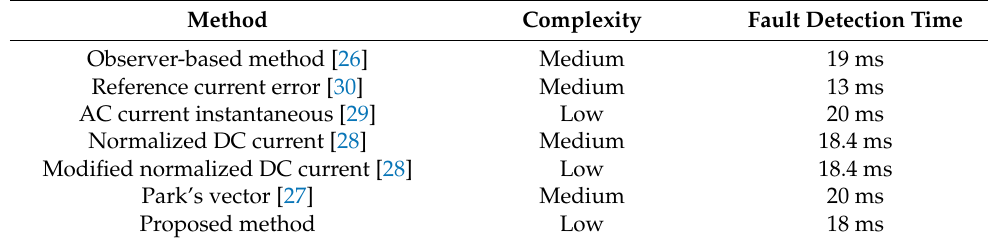
Table 2. Proposed fault diagnosis algorithm compared with other